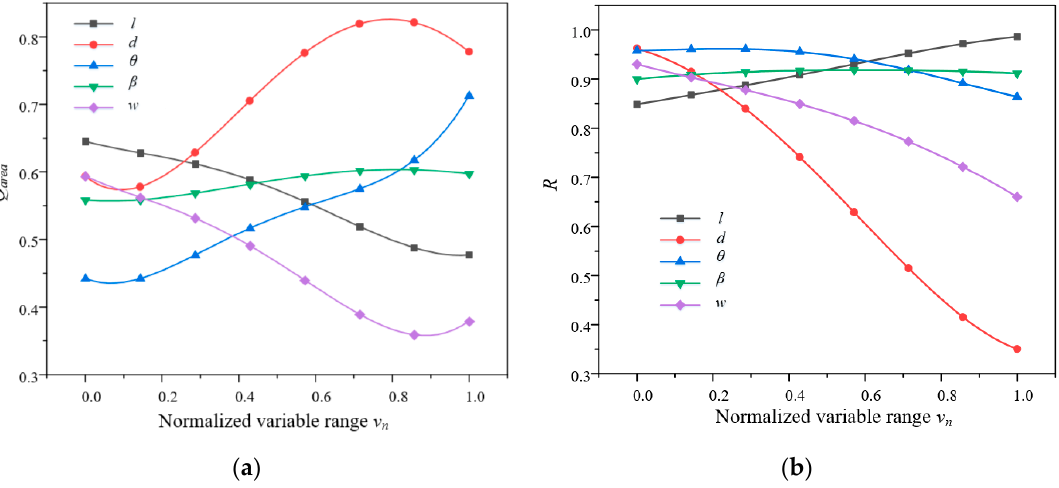
Figure 7. Effects of design parameters on foil performances. ( a ) Q votex isosurface(Q area = 2×10 7 ), ( b ) lift drag ratio.